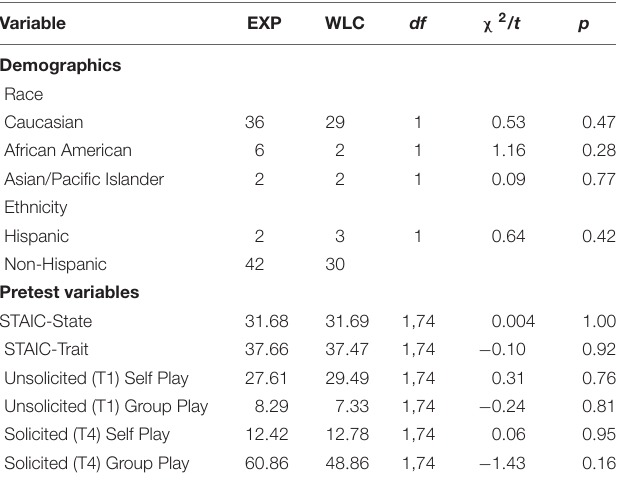
TABLE 1 | Demographic and pretest